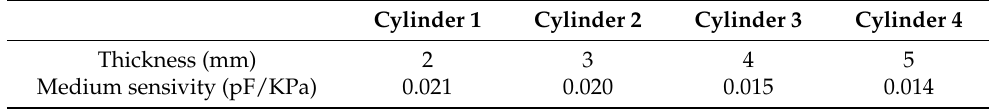
Table 1. Sensitivity values and range for cylinders.